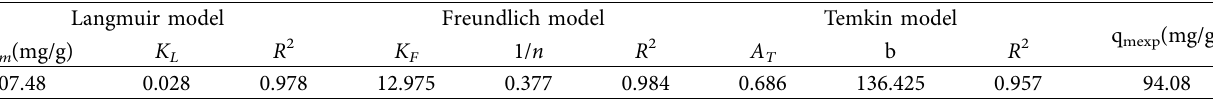
Figure 8: Adsorption isothermal equilibrium tendency of RhB onto CAC/CoFe 0.05mg/25mL, and the initial pH of 4.